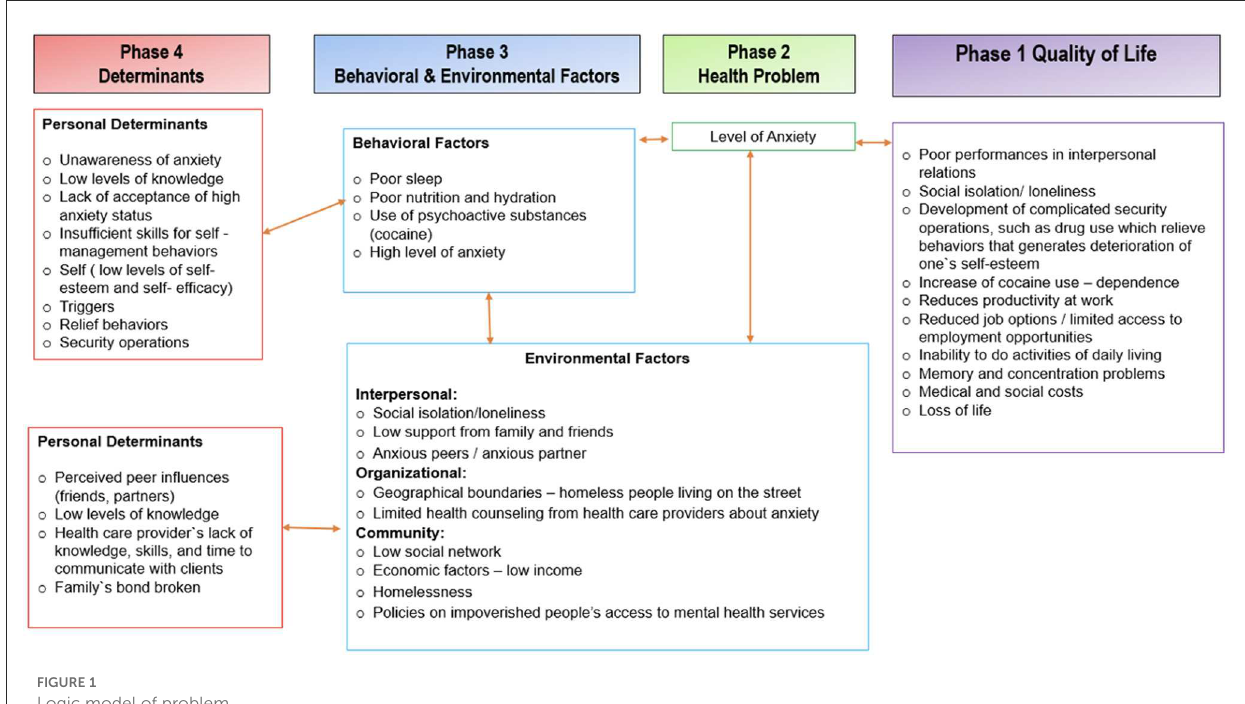
FIGURE1 Logic model of